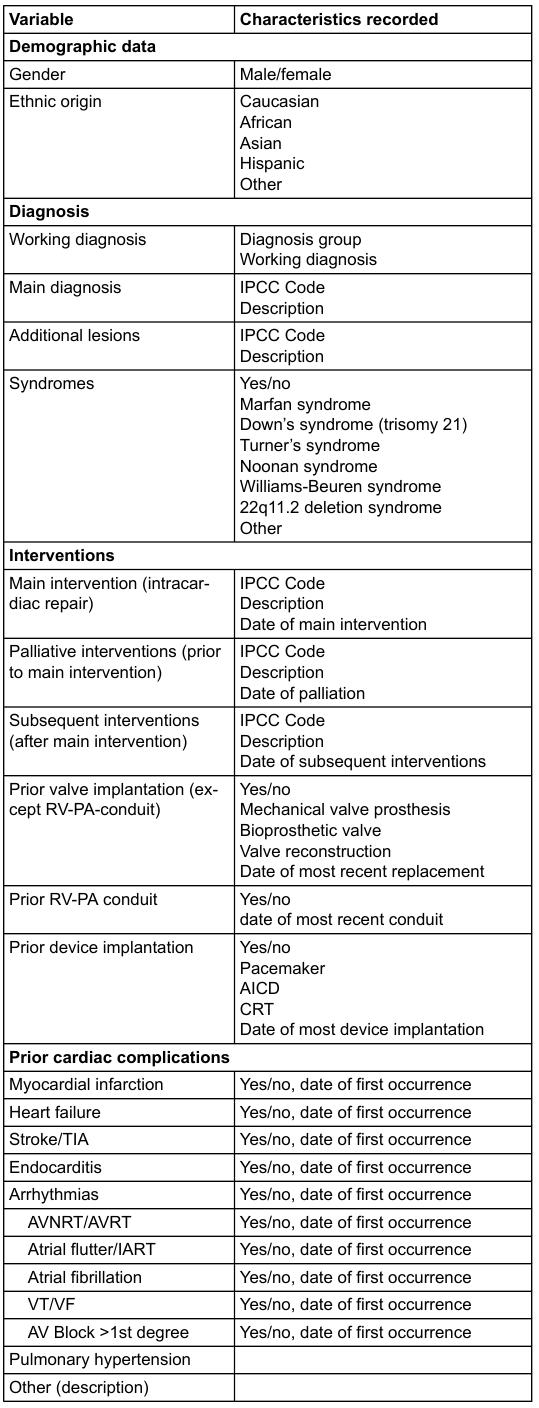
Table 1: Case reporting form for baseline